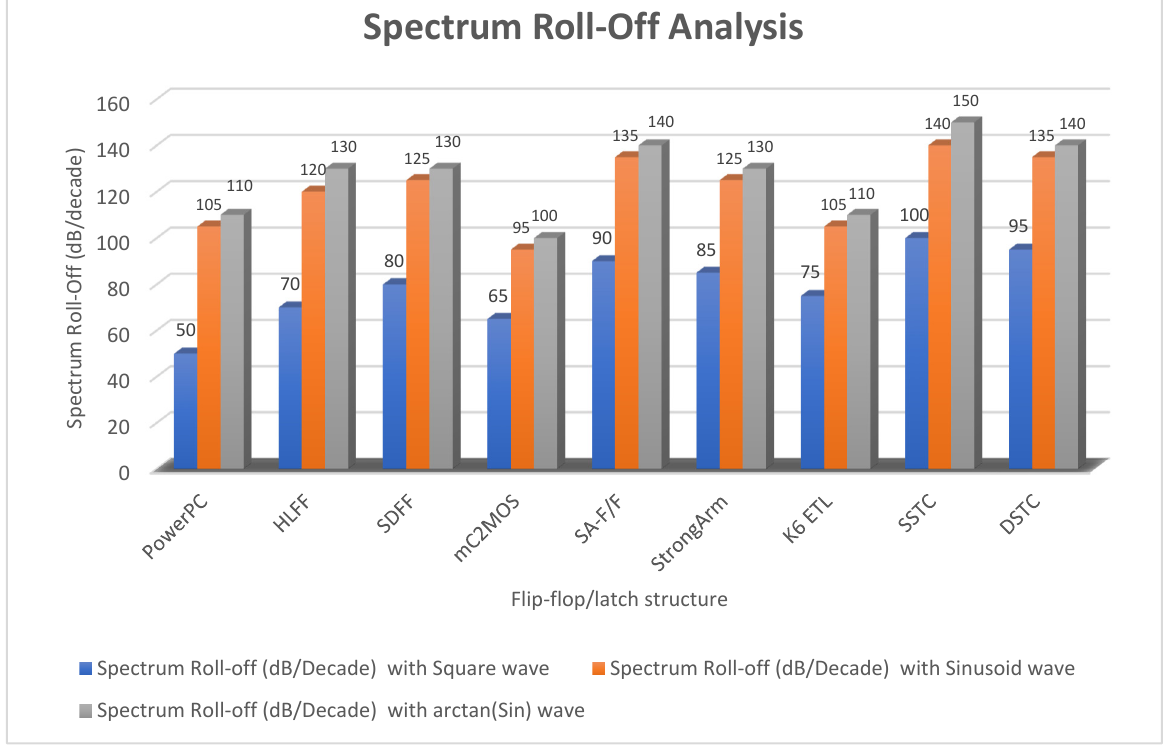
Figure 12. Spectrum roll-off analysis using 65 nm process technology and various types of input signals.